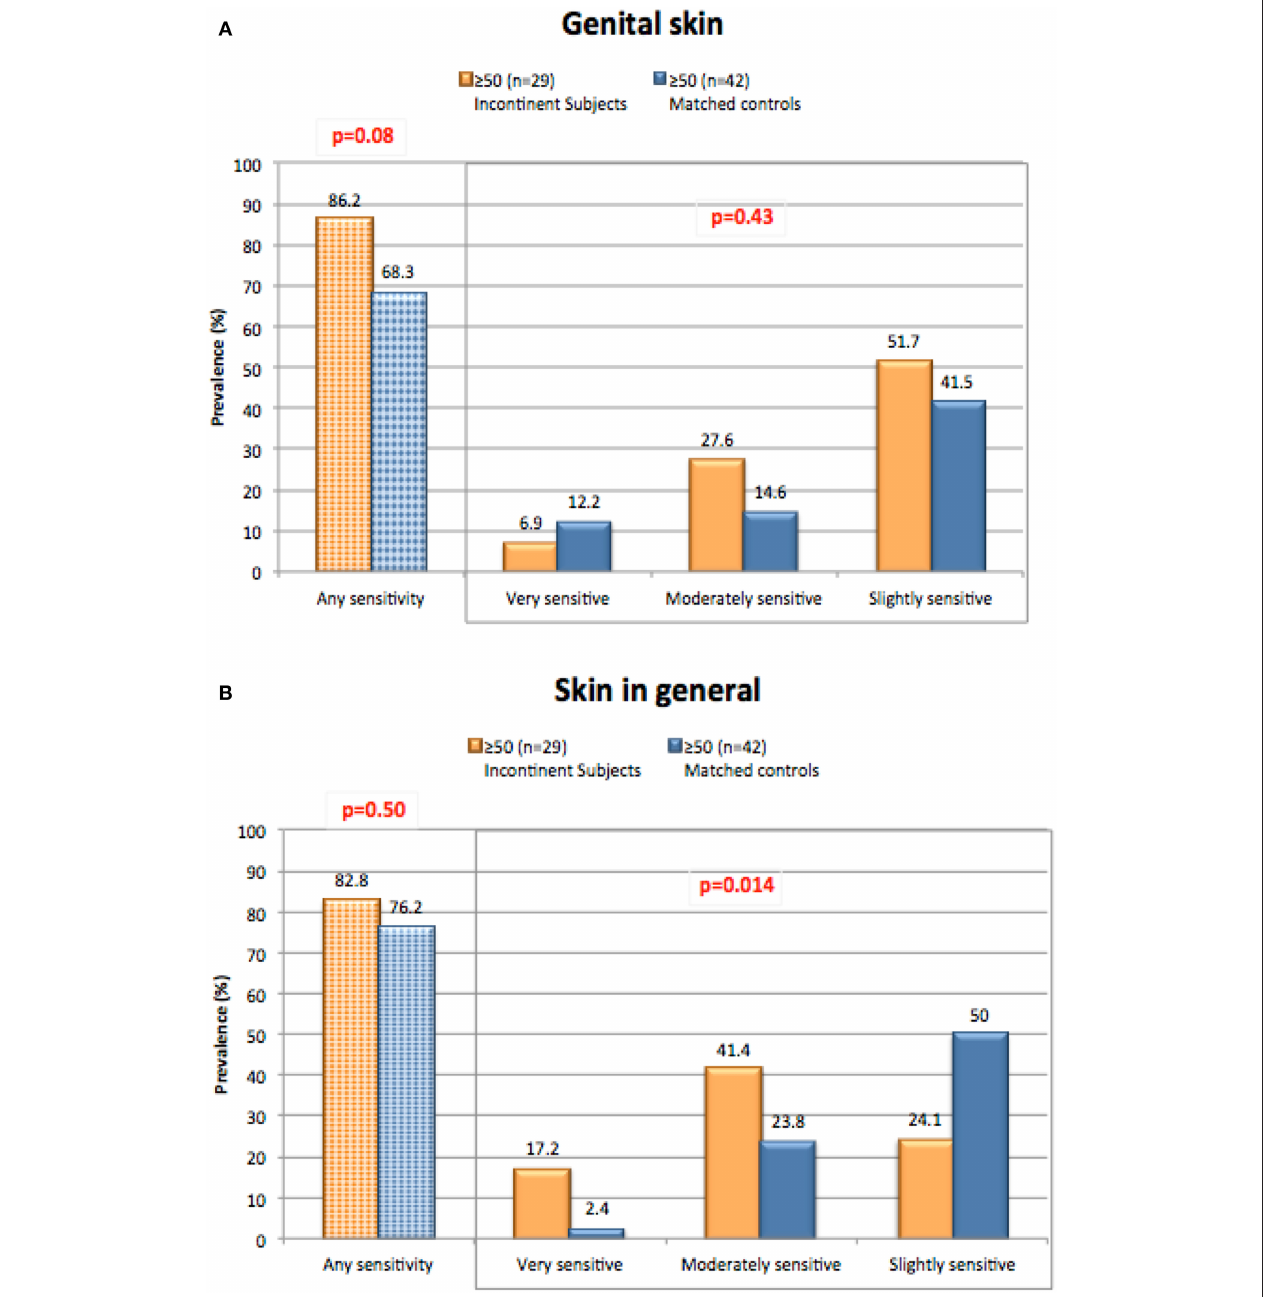
FIGURE 5 | Perceptions of sensitive skin among women with incontinence. The sensitive skin questionnaire was administered to women who suffered from light urinary incontinence age 50 and above. Responses were compared to age matched control subjects who do not have incontinence. The percentage of participants claiming any degree of skin sensitivity, and the percentage giving each degree of response (i.e., very, moderately, or slightly) are plotted. Results were compared for any degree of sensitivity using a Chi-square analysis, and for all three degrees of sensitivity using a Mantel-Haenszel chi-square analysis. (A) Sensitive genital skin, (B) sensitive skin in general. [Data adapted from Farage